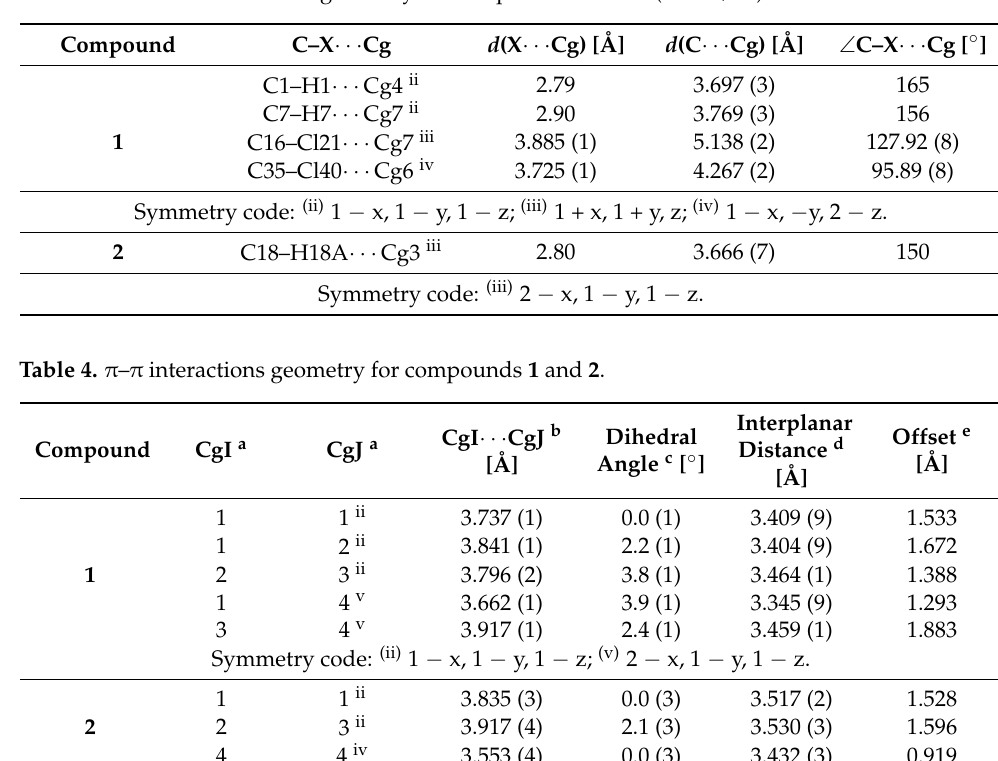
Table 3. C–X · · · π interactions geometry for compounds 1 and 2 (X = H/Cl).